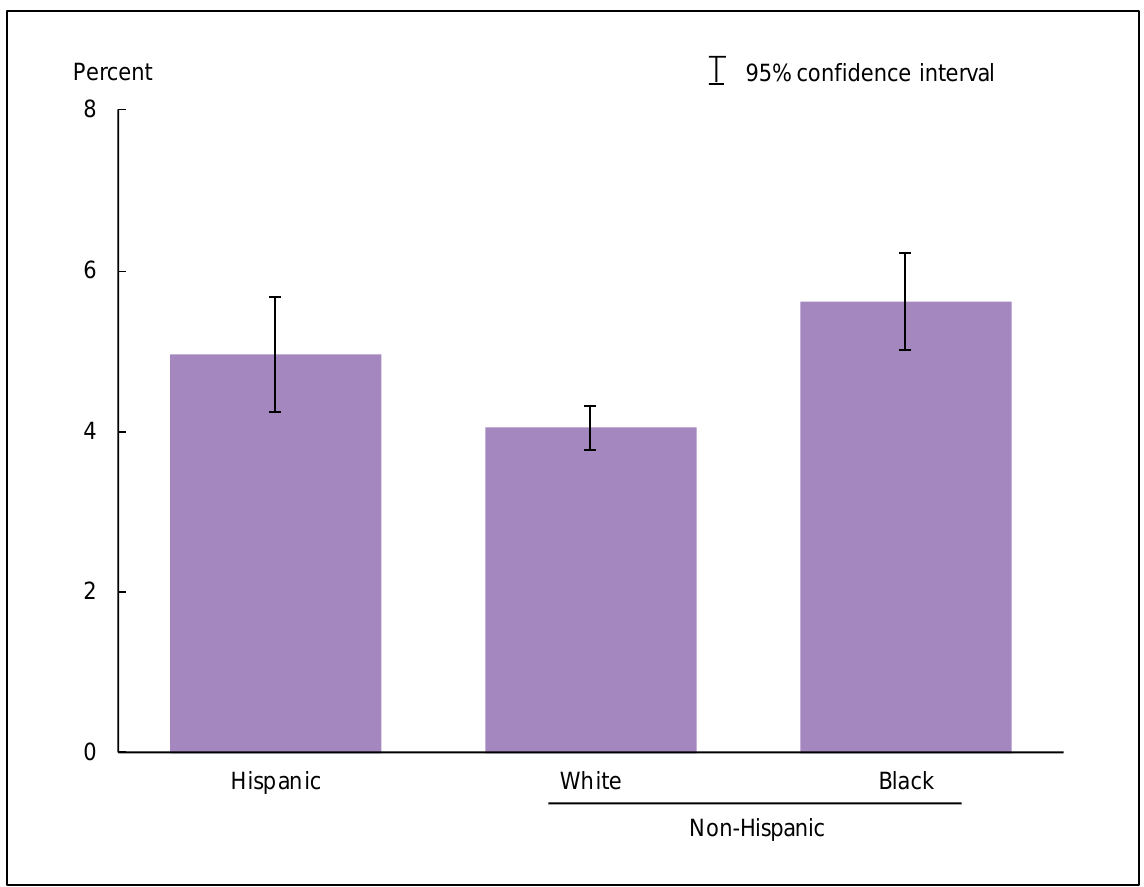
Figure 3.3. Age-sex-adjusted percentage of persons of all ages who failed to obtain needed medical care due to cost at some time during the past 12 months, by race and ethnicity: United States,